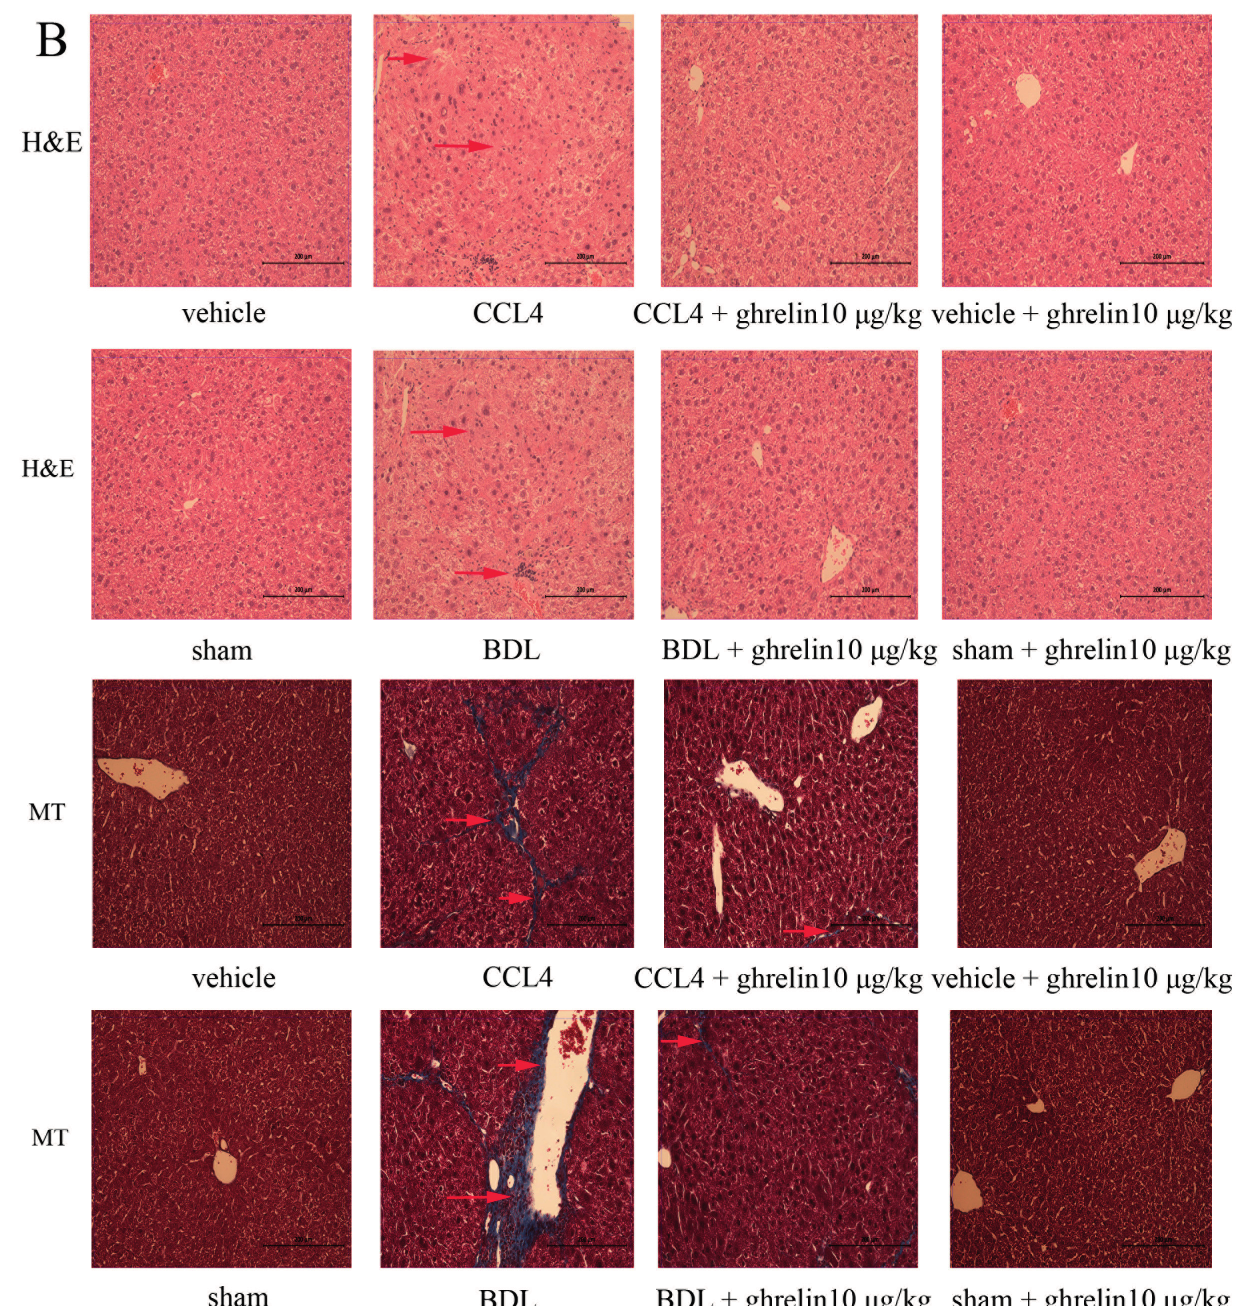
Figure 1. Effect of ghrelin on CCl 4 - and BDL-induced liver fibrosis. ( A ) Ghrelin decreased the levels of ALT, AST, and hydroxyproline. Data are expressed as the mean ± SD ( n = 7, * p < 0.05 for CCl 4 or BDL group vs. the vehicle or sham group, # p < 0.05 for CCl 4 + ghrelin or BDL + ghrelin group vs. the CCl 4 or BDL groups); and ( B ) Ghrelin ameliorated pathological changes to the liver, as demonstrated by H & E and Masson’s trichrome (MT) staining (original magnification: 200×). Red arrows indicate damaged liver tissue and fiber cords. BDL: bile duct ligation; ALT: alanine transaminase; AST: aspartate transaminase; H & E: hematoxylin and eosin; MT: Masson’s trichrome. The scale bar of each figure is 200 μ m, and the magnification is